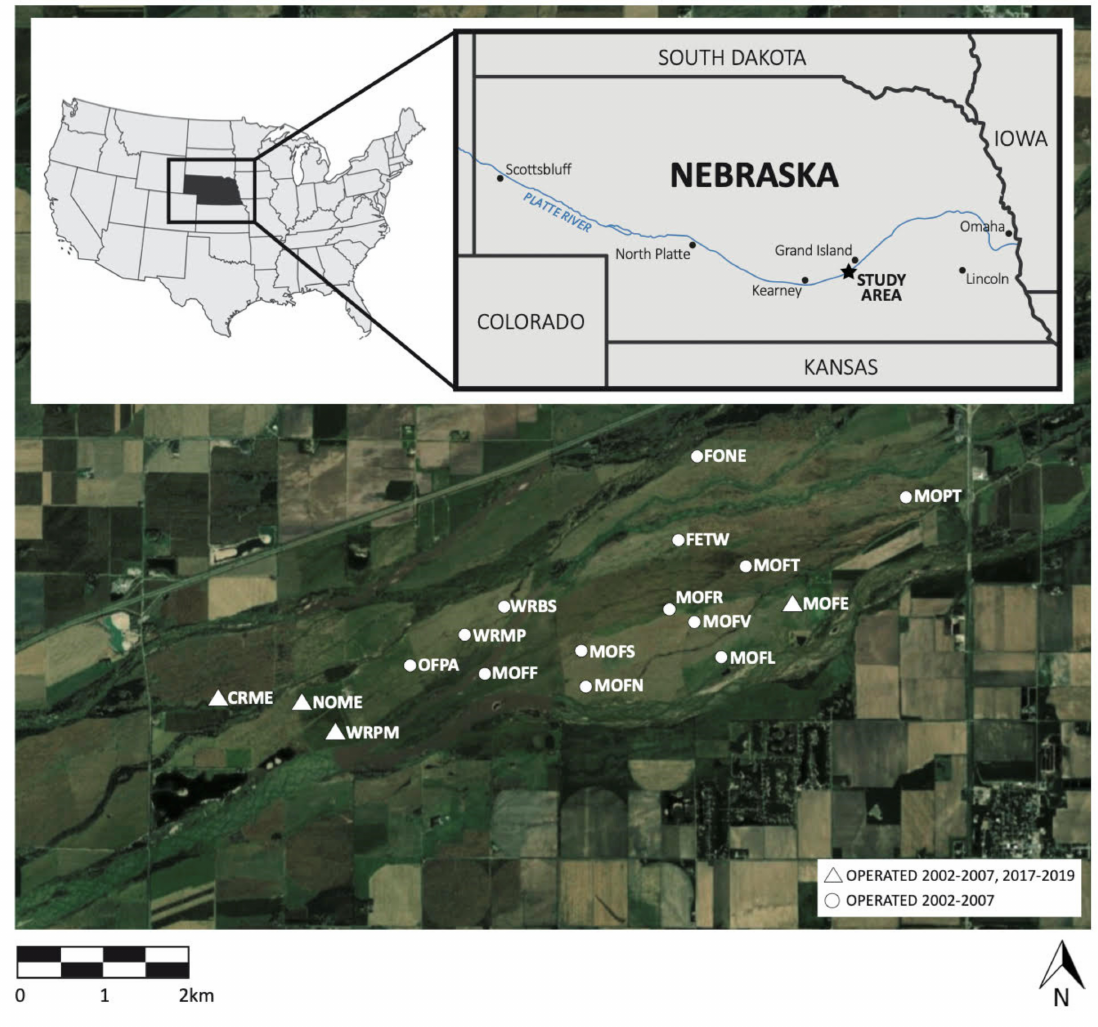
Figure 1. Map of the study area showing bird sampling sites in the Platte River Valley, Nebraska, USA. Circles represent ~8 ha sites run 2002–2007; triangles represent ~8 ha sites operated in both 2002–2007 and 2017–2019. Map produced by R.H.K. using ArcGIS software release 10.6, Redlands, CA: Environmental Systems Research